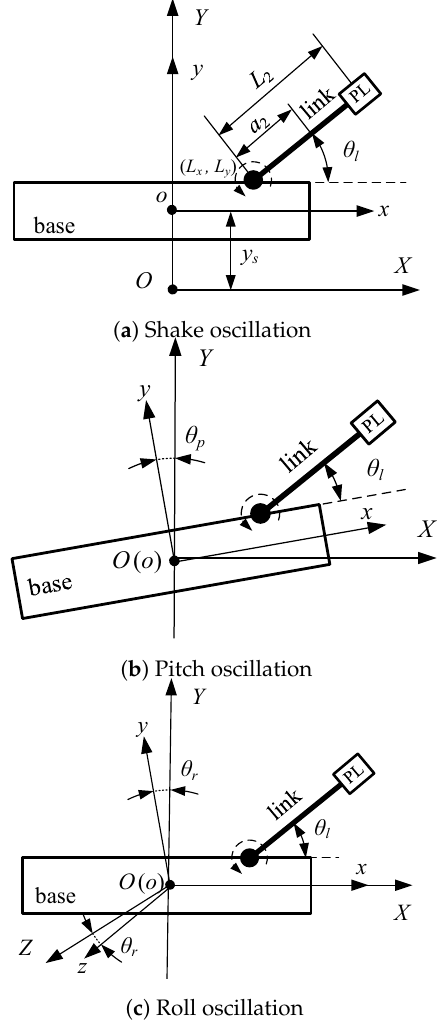
Figure 2. Simplified model of the OBMs system with three base